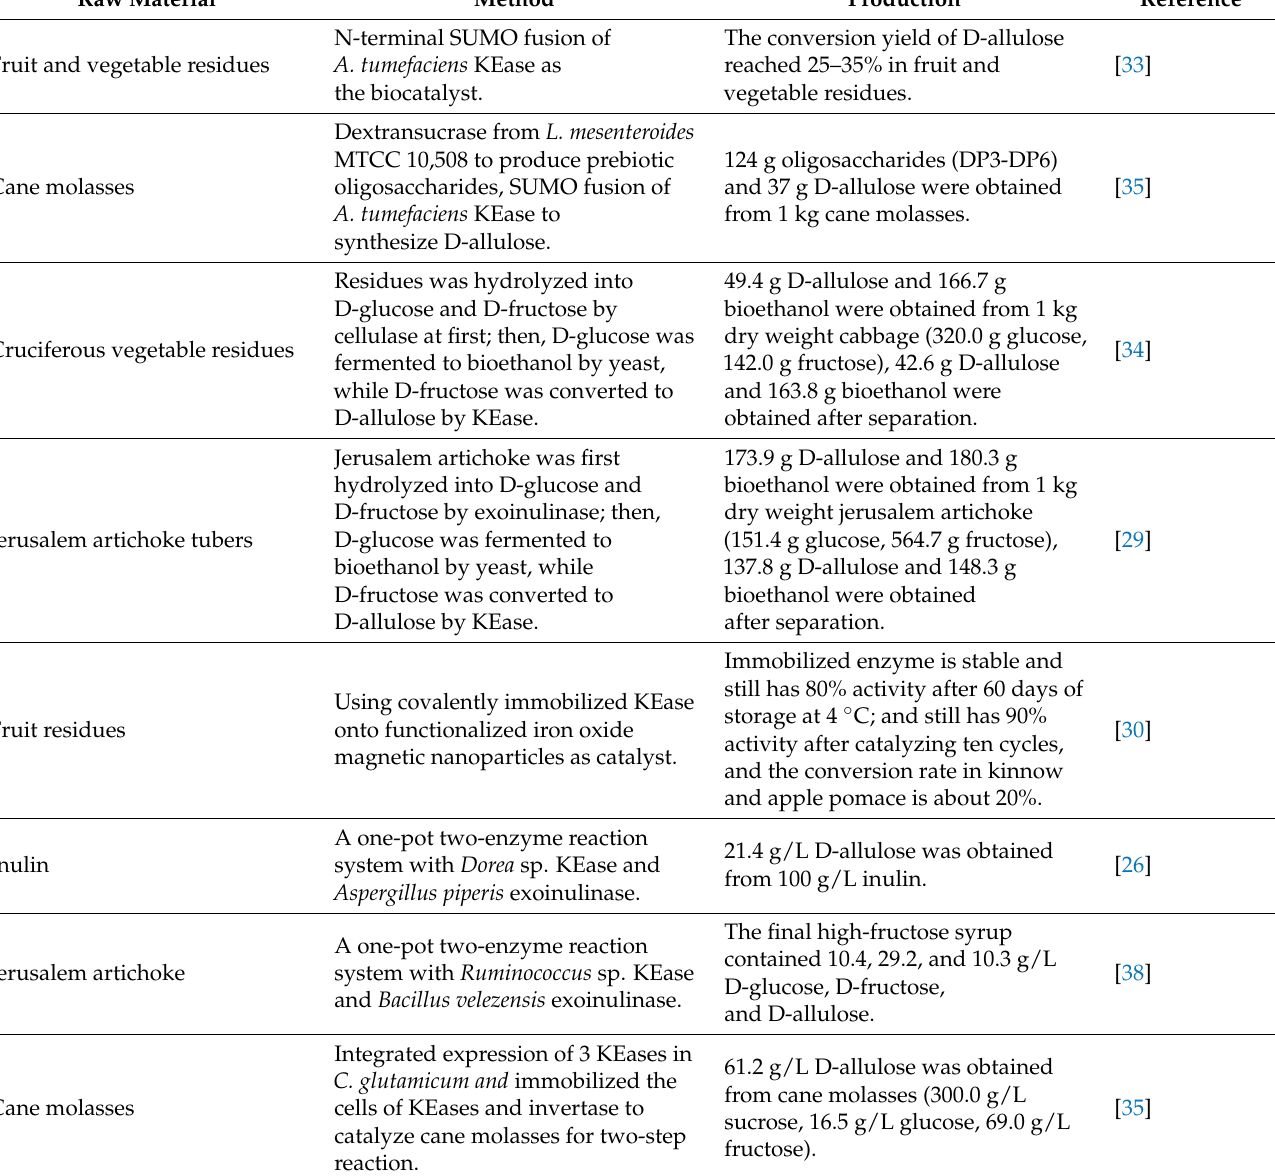
Table 1. Bioproduction of D-allulose from